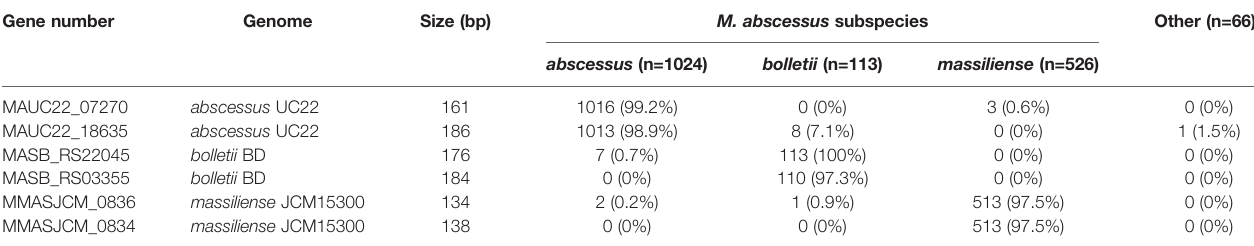
TABLE 2 | In silico PCR validation of M. abscessus subspecies-speci fi c PCR